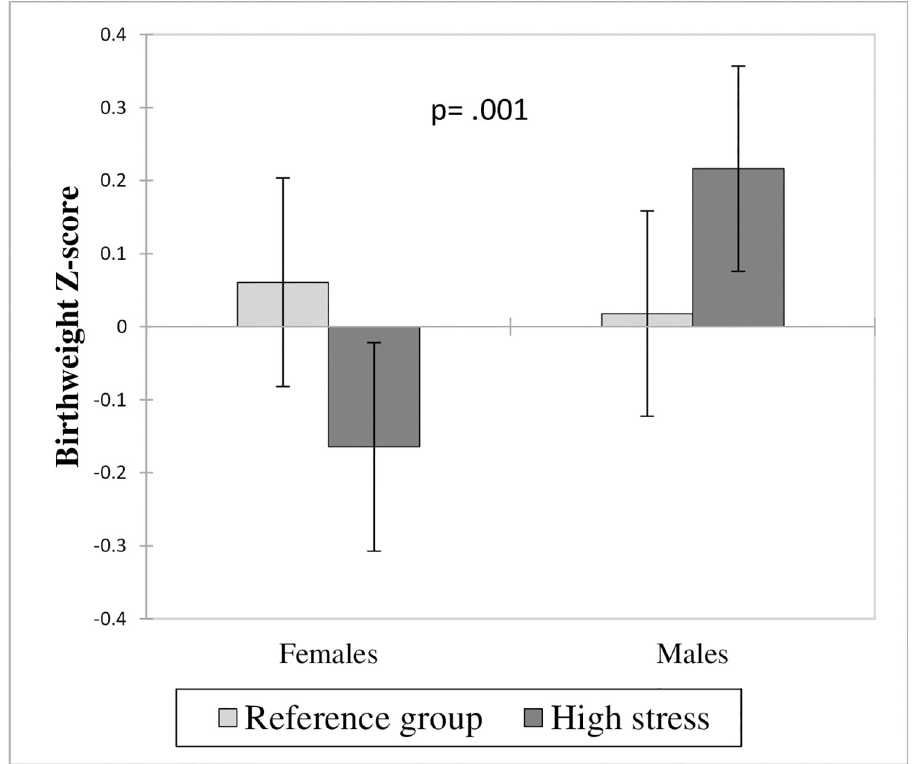
Fig 3. Neonate birthweight Z-score as a function of sex of the newborn according to maternal psychological stress during pregnancy. Results presented as Least Square (LS) means with CI 95% ; variables included in the model: maternal age, pre-pregnancy BMI, weight gain during pregnancy, parity, presence of GDM and HDP, gestational age at delivery, smoking status, level of stress, sex of the newborn, and ‘level of stress � sex of the newborn’ interaction.